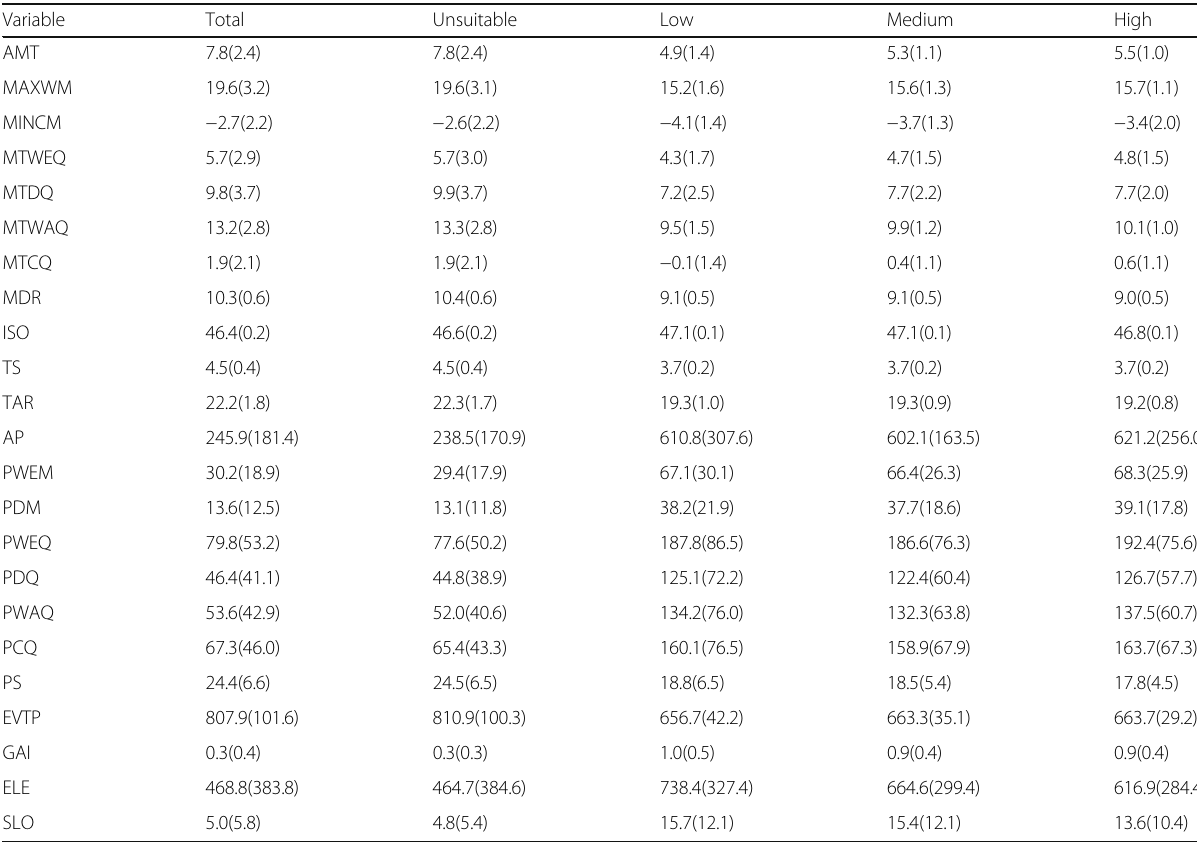
Table 3 Characterization (mean and standard deviation) of the climatic and topographic variables of the potential habitat suitability map of huemul classified according to their values: Total represents the values of the entire province, while unsuitable (<40%), low (40 – 50%), medium (50 – 70%), and high (70 – 100%) were classified according to the modeling